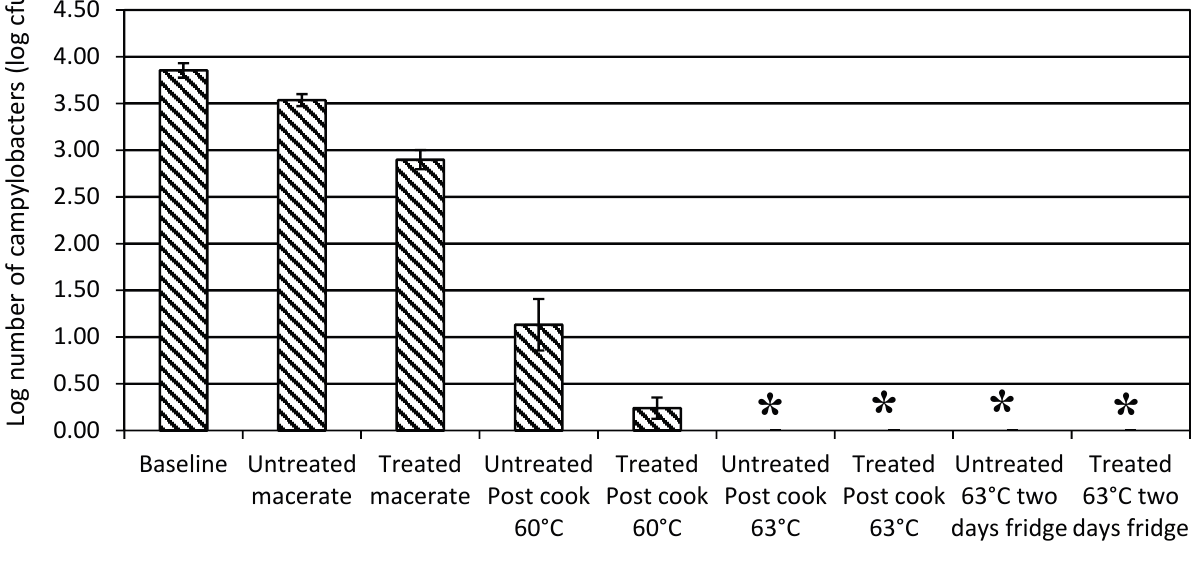
Figure 6. The numbers of campylobacters remaining after imperfect cooking of contaminated livers to 60 °C or 63 °C. Livers were treated by washing in organic acid and exposed to essential oils (EO) and compared with livers that were not washed in organic acid or exposed to EO to determine if treatment conferred additional safeguards. Error bars are the standard error of the mean log. An asterisk ( * ) denotes a sample that did not contain campylobacters determined by